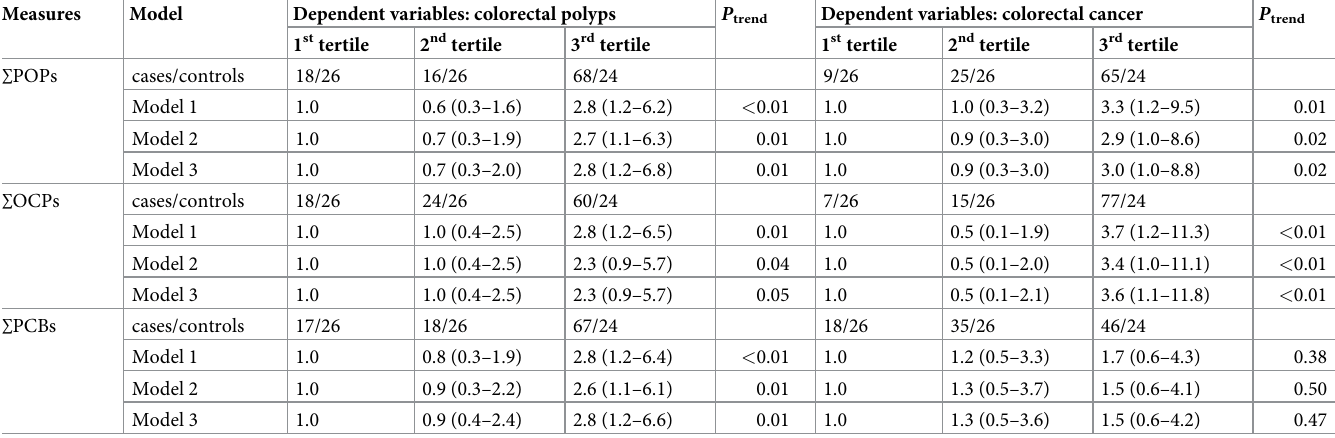
Table 3. Associations between the summary measures of persistent organic pollutants, organochlorine pesticides, and polychlorinated biphenyls and the risk of colorectal polyps or cancer, calculated using polychotomous logistic regression (Odds ratios and 95% confidence intervals). Measures Model